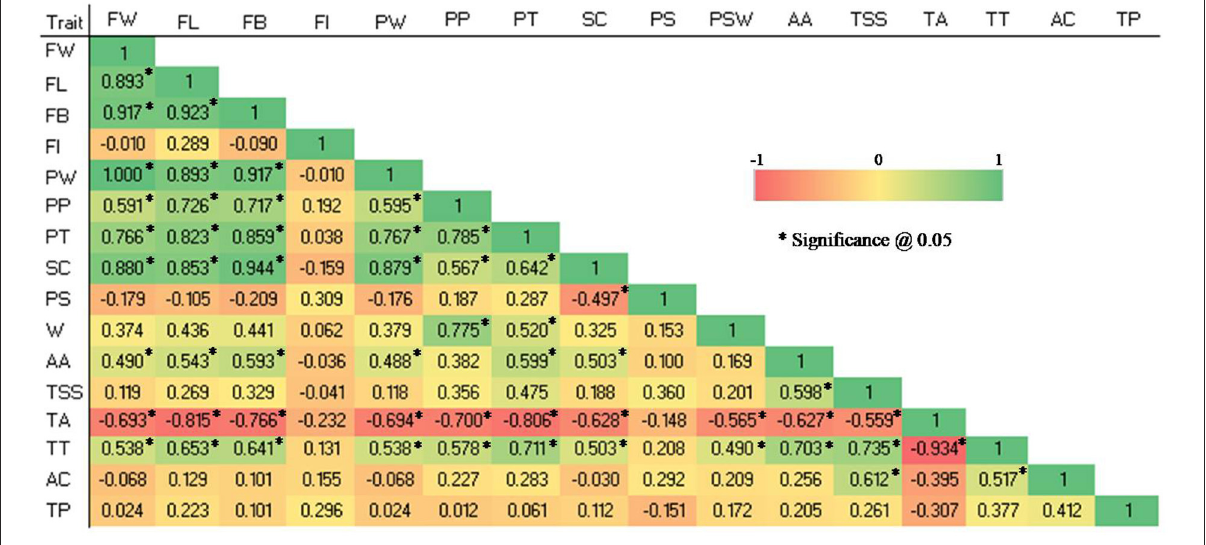
FIGURE4 Pearson correlation coefficient among 16 quantitative traits in 28 guava germplasm. FW, fruit weight; FL, fruit length; FB, fruit breadth; FI, fruit index; PT, pulp thickness; SC, seed core cavity; PS, pulp thickness: seed core cavity ratio; PW, pulp weight; PP, pulp percent; PSW, pulp: seed weight ratio; AA, ascorbic acid; TSS, total soluble solids; TA, titratable acidity; TT, TSS, TA ratio; AC, Antioxidant capacity and TP, total phenolic